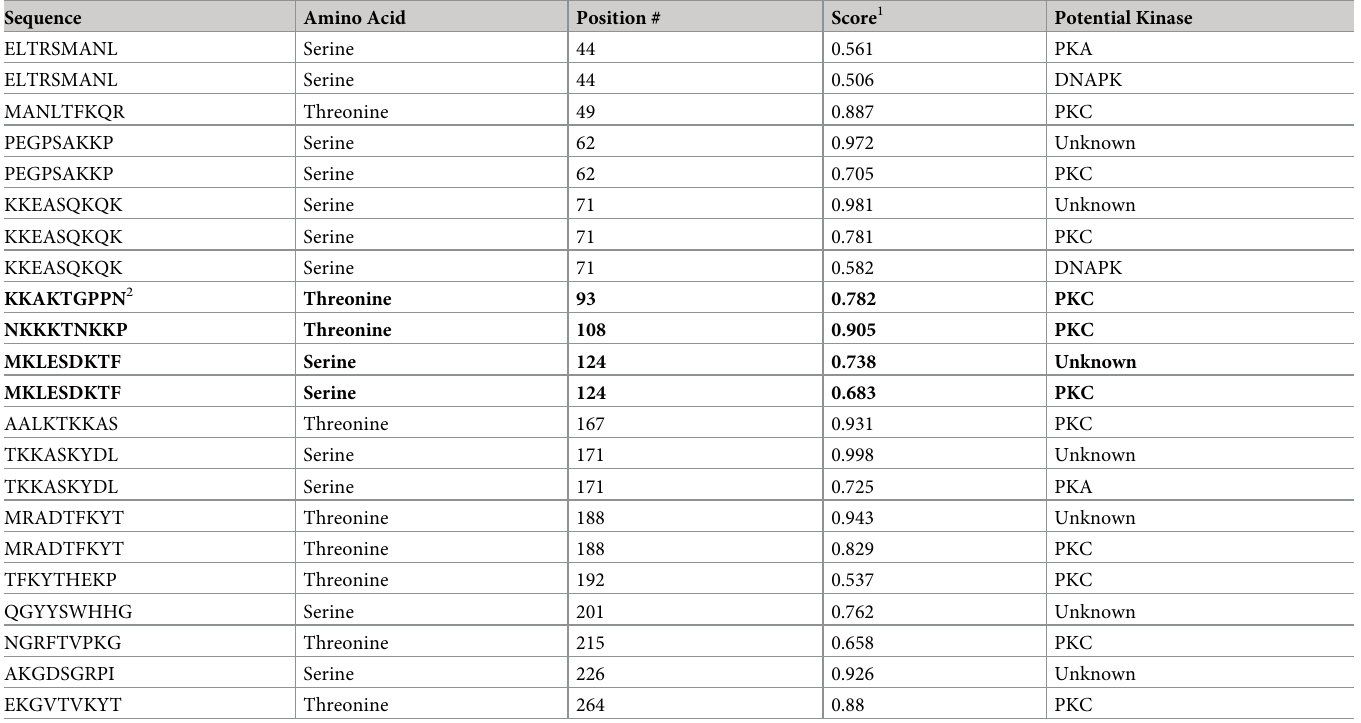
1 Score is the confidence that the software has of the site being a true phosphorylation site. Values above 0.500 are considered above the threshold 2 Bolded information indicates sites that were previously experimentally shown to be phosphorylated [24]. 3 Predicted tyrosine phosphorylations are not